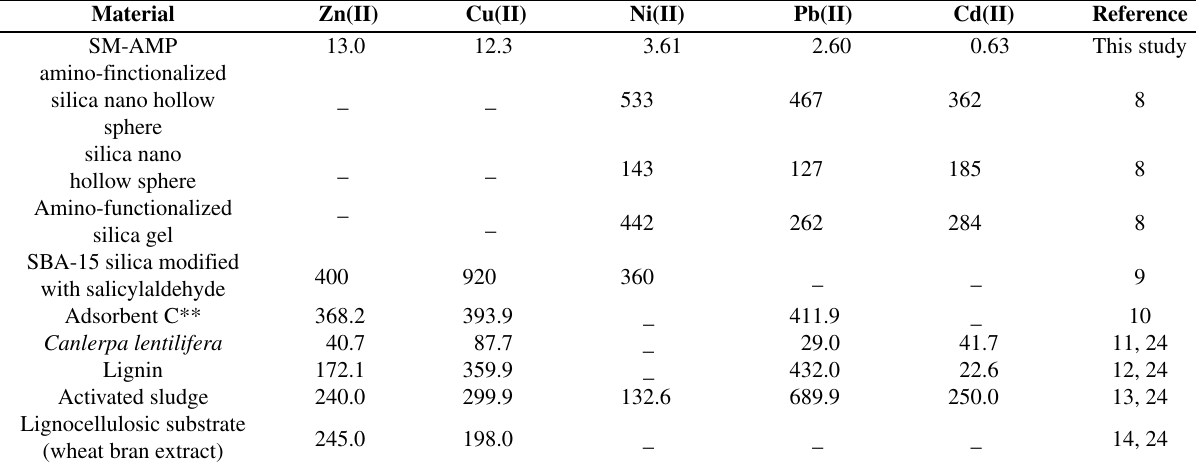
Table 4. Comparison between the maximum adsorption capacities (in μmol g –1 * ) for different sorbent materials. Material